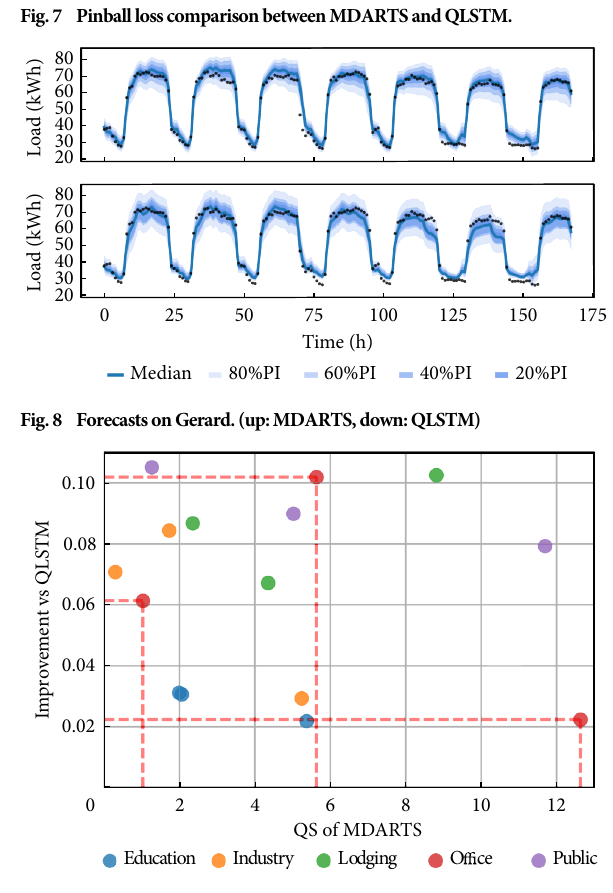
Fig. 9 Forecasting performance of our proposed MDARTS for each build- ing.